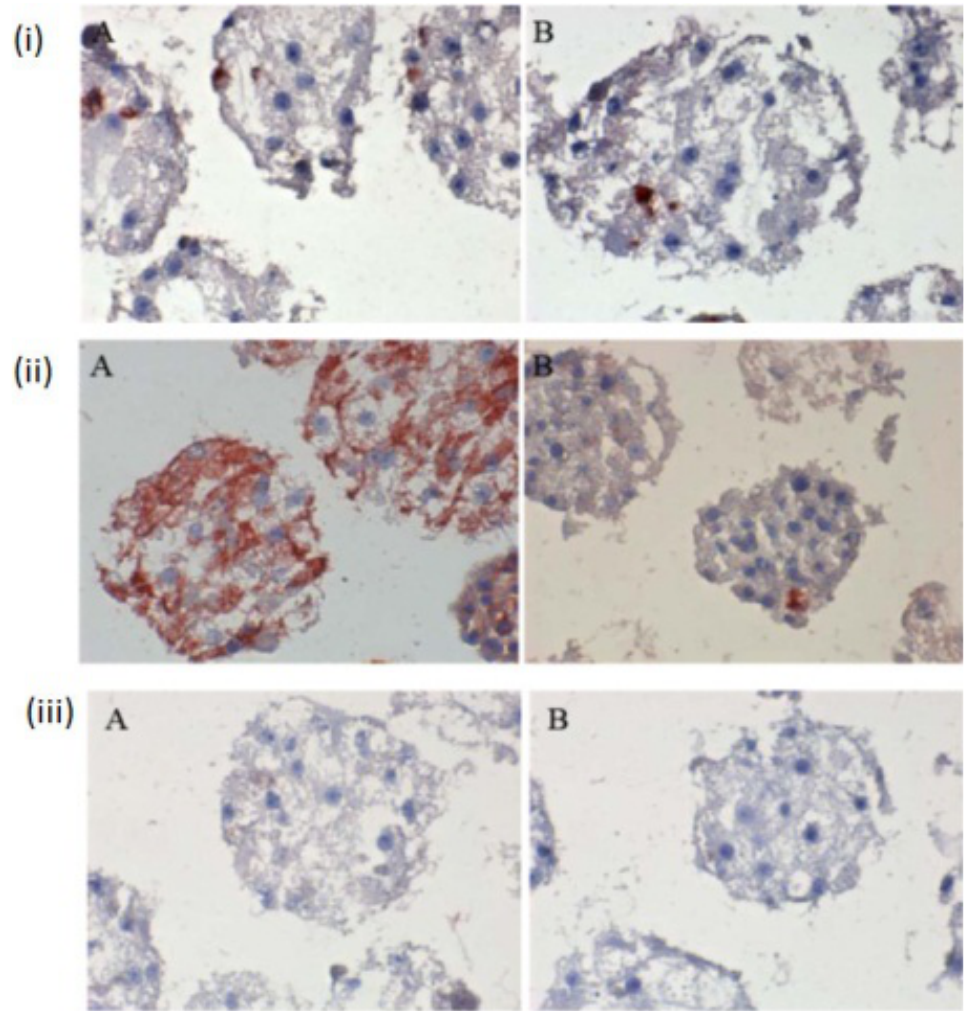
2.3. Vitality of Hepatocytes and Apoptotic Test in Different Positions in the Spheroid